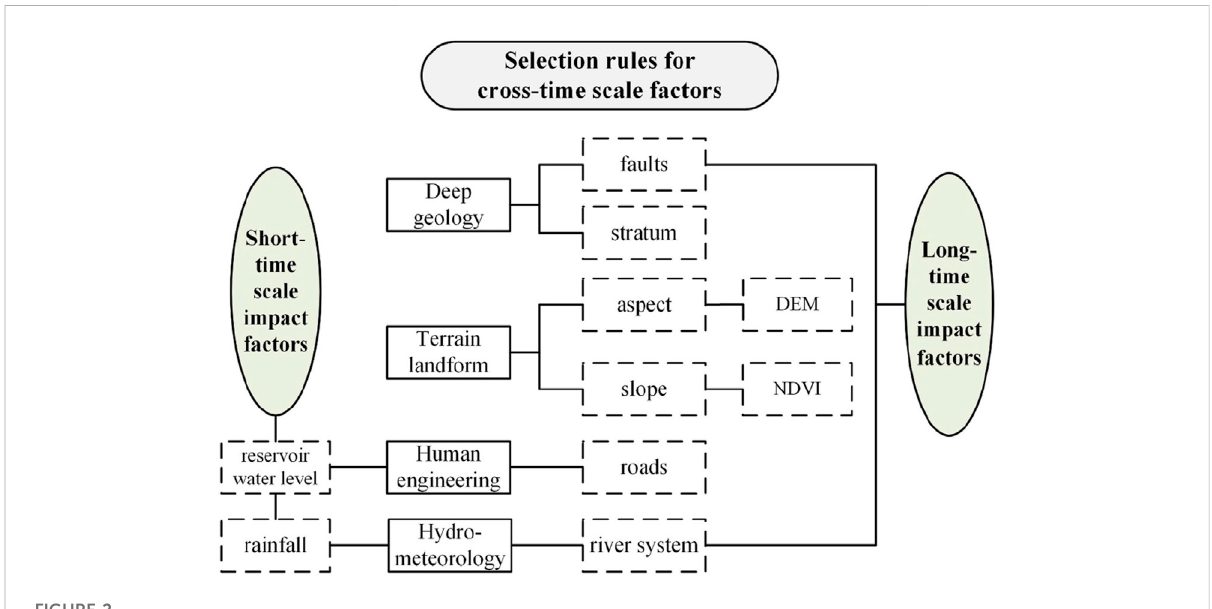
FIGURE 2 Selection rules for cross-time scale